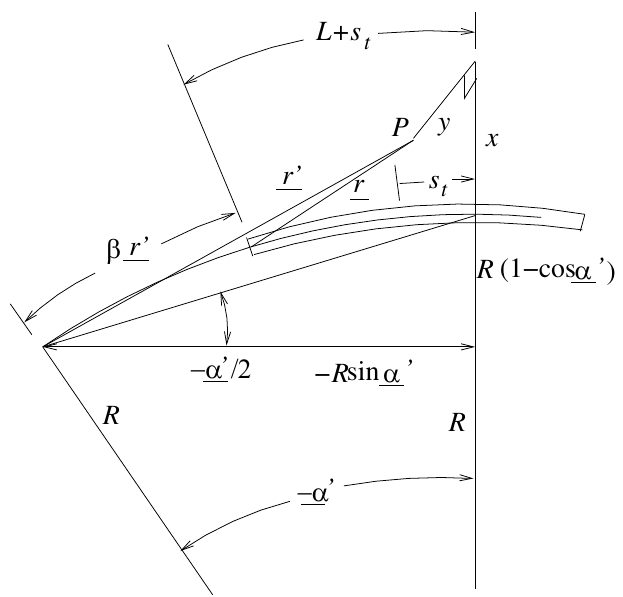
FIG. 9. Geometry for interpreting short bunch approxima-